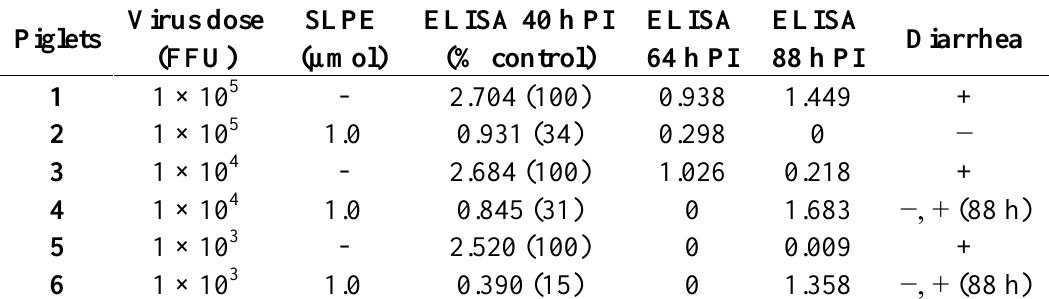
Table 1. Effect of single dose SLPE on virus shedding in rotavirus inoculated piglets.